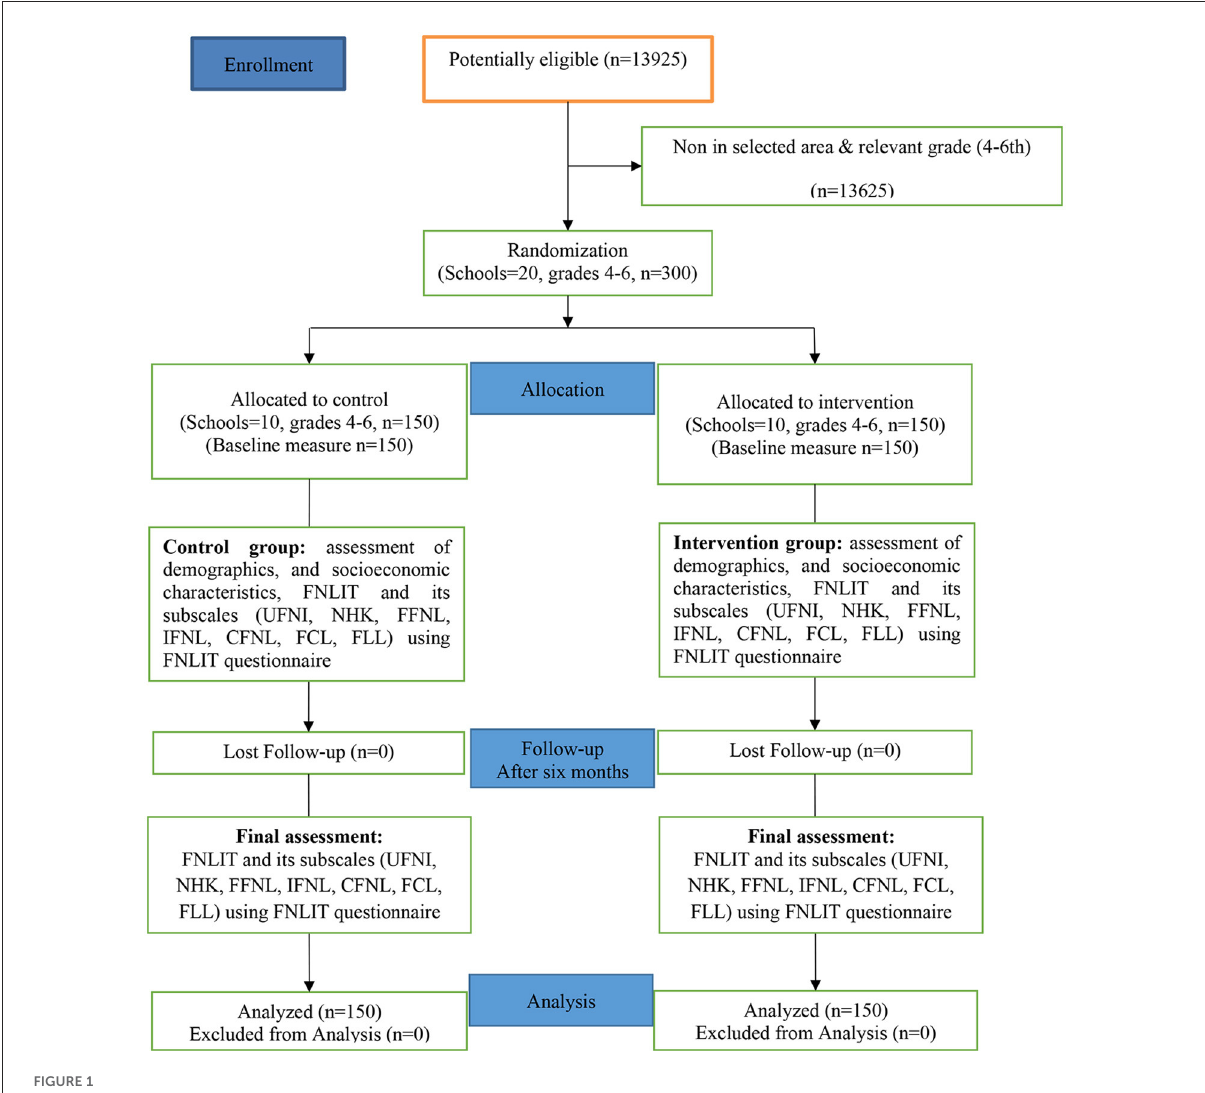
FIGURE1 CONSORT flow